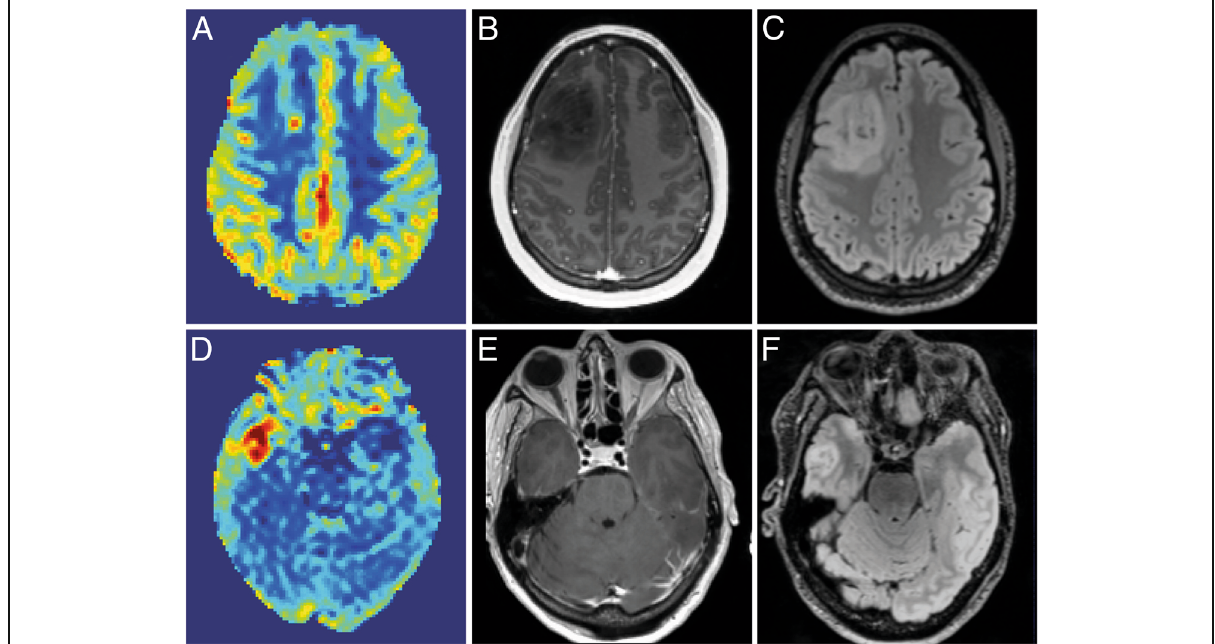
Fig. 2 a – c Example of a 24-year-old female patient, with oligodendroglioma (grade II) in the left frontal lobe. a Cerebral blood flow, imaged by ASL. Red indicates high blood flow. b T1-Gd and c FLAIR. d – f Example of a 63-year-old female patient with GBM (grade IV) in the right temporal lobe. d Cerebral blood flow, imaged by ASL. Red indicates high blood flow. e T1 post Gd. f FLAIR. A clear difference in tumour blood flow can be seen between both patients (courtesy: A. Alsaedi, S.